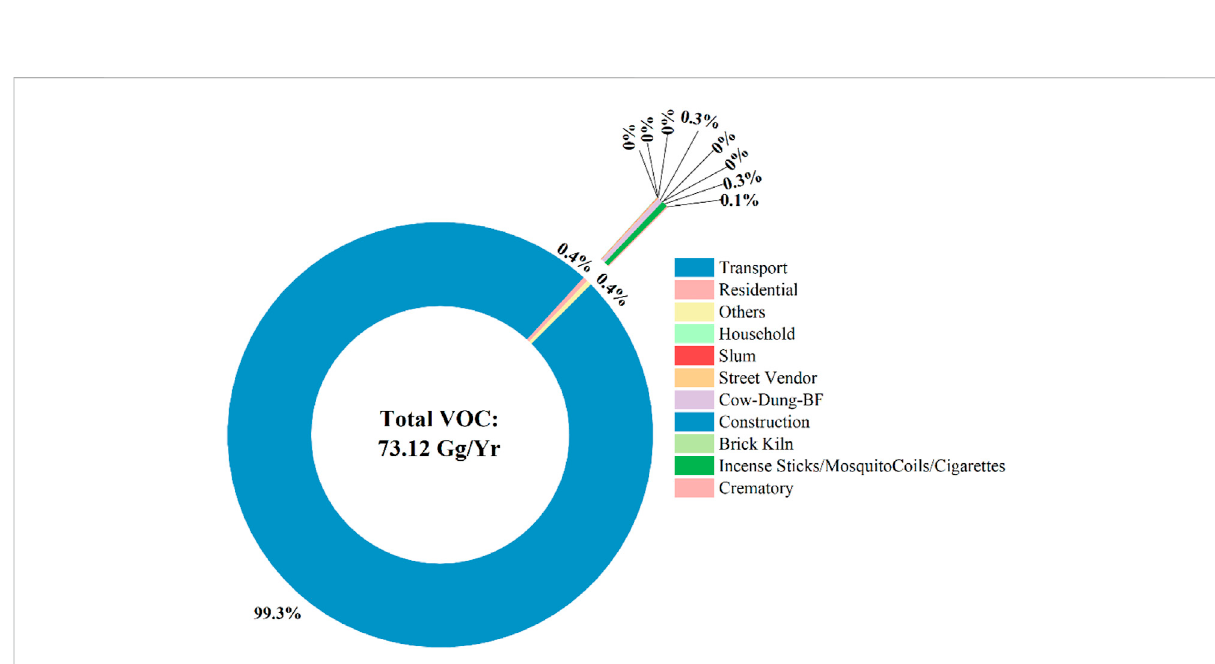
FIGURE 8 Contribution of VOC from major and minor